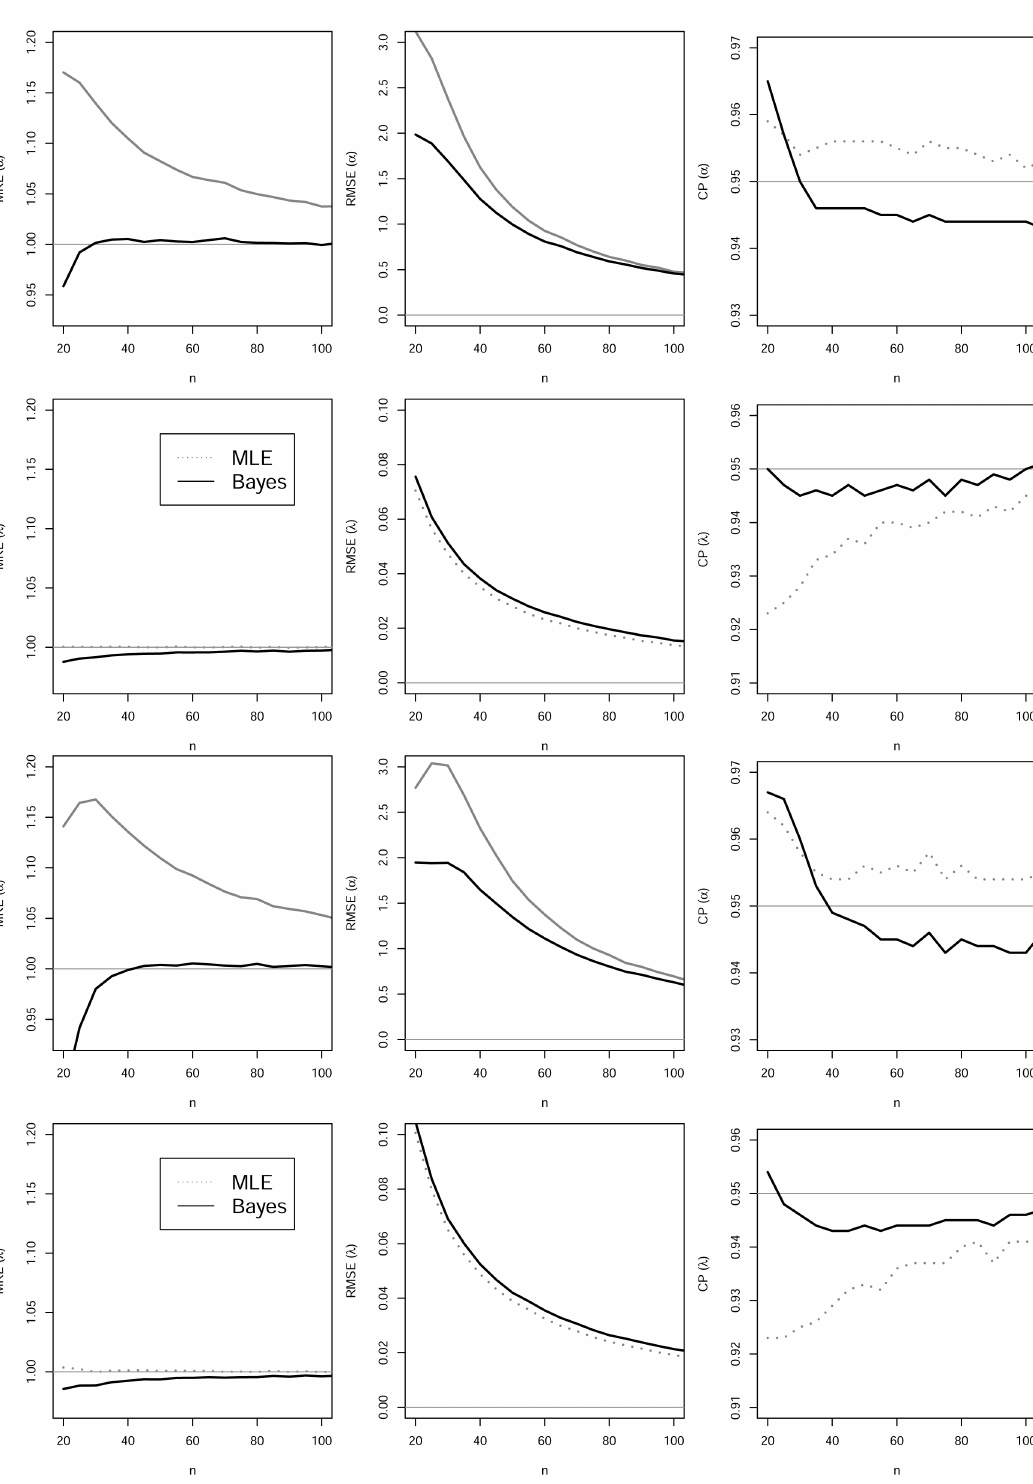
An Acad Bras Cienc (2019) 91(3) e20190002 16 |